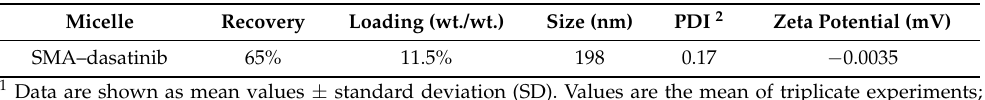
Table 1. Characterization of SMA–dasatinib 1 .